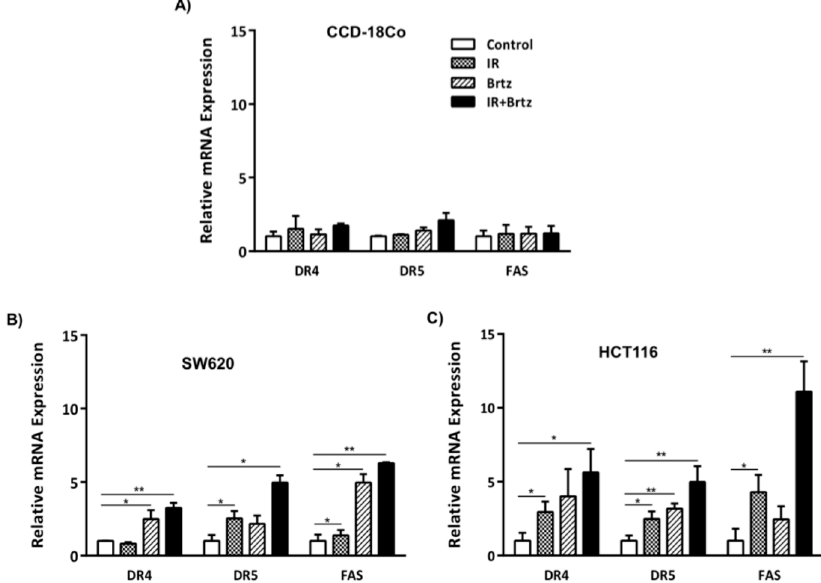
Figure 3. Inhibition of the 26S proteasome enhances transcript expression of death receptors with combination of radiation in tumor cells. Following the treatments, adherent cells were harvested, RNA was extracted and cDNA was generated. Data was quantified using qRT-PCR with primers and probes specific for DR4, DR5 or Fas coding regions and the obtained data were normalized to housekeeping gene HPRT1 expression. Graphed data shows the average of three independent experiments, with error bars denoting SEM. * p < 0.05, ** p < 0.005. Relative mRNA expression of DR4, DR5 and Fas in ( A ) CCD-18Co, ( B ) SW620 ( C ) and HTC116 cells.